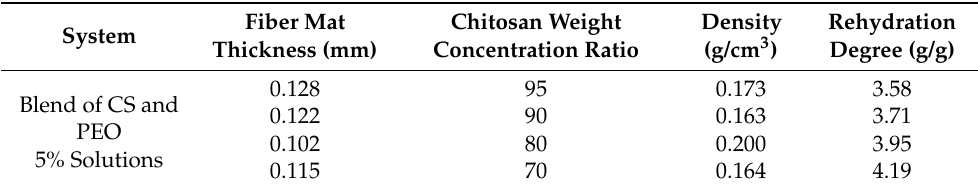
Table 3. Degree of rehydration of nanofibers produced at different CS/PEO ratios after neutralization,